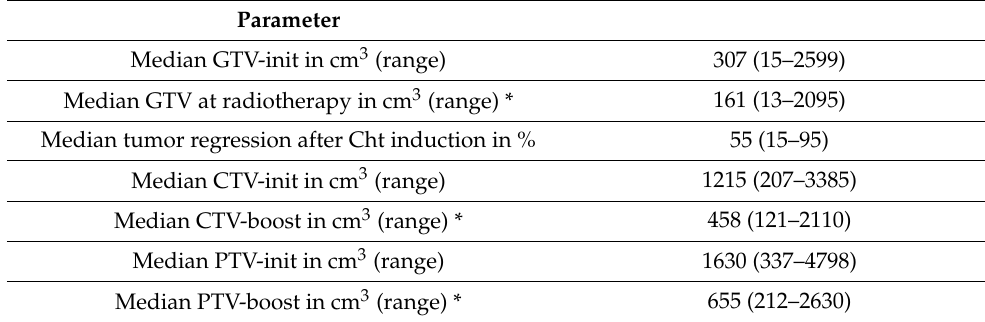
Table 2. Tumor and target volumes.